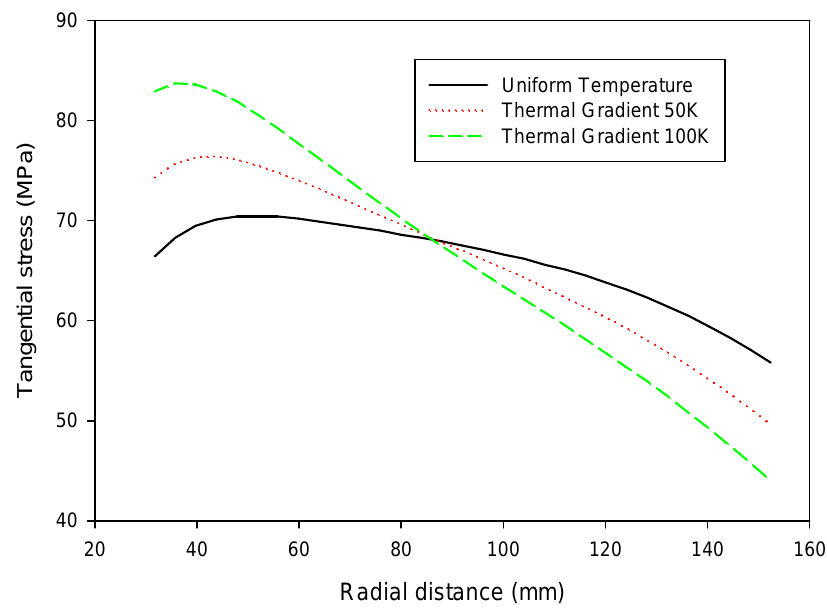
Figure 2. Variation of tangential stress along the radial distance with composite disc with/without thermal gradient.